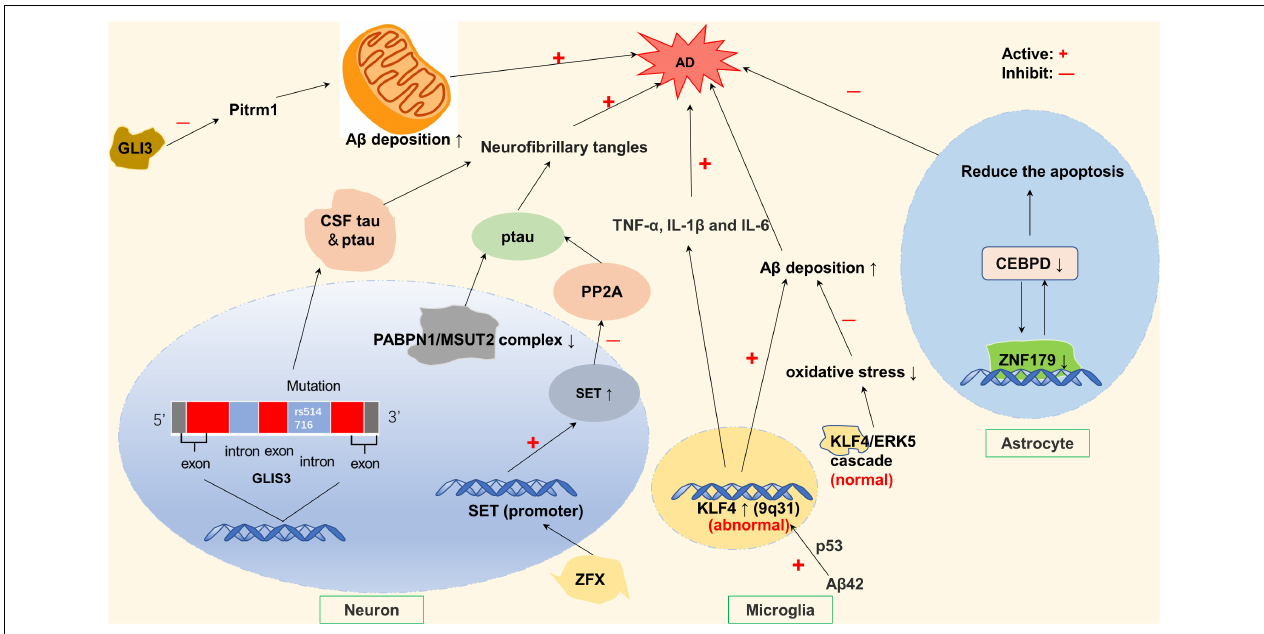
FIGURE 1 | Zinc finger proteins (ZNF) associated with Alzheimer’s disease (AD). Rs514716 in GLIS3 is associated with cerebrospinal fluid (CSF) tau and ptau levels, which is a risk gene for AD. ZFX can activate SE translocation (SET) promoter and inhibit PP2A phosphatase, resulting in tau hyperphosphorylation. Loss of PABPN1/MSUT2 complex can aggravate the severity of AD. The oligomer AB42 increased the expression of KLF4, and the overexpression of KLF4 increased the increase of TNF- α , IL-1 β , and IL-6, thereby exacerbating AD. However, under normal conditions, ERK5/KLF4 cascade reaction can avoid oxidative stress-induced neuronal death. GLI3 expression inhibited the activity of endometrial peptidase and reduced the degradation of A β in mitochondria. CCAAT/enhancer binding protein delta (CEBPD) is an upstream regulator of the ZNF179 gene in astrocytes. CEBPD regulates the transcription of ZNF179 by directly binding to the promoter region of ZNF179 and exerts an anti-apoptotic effect on